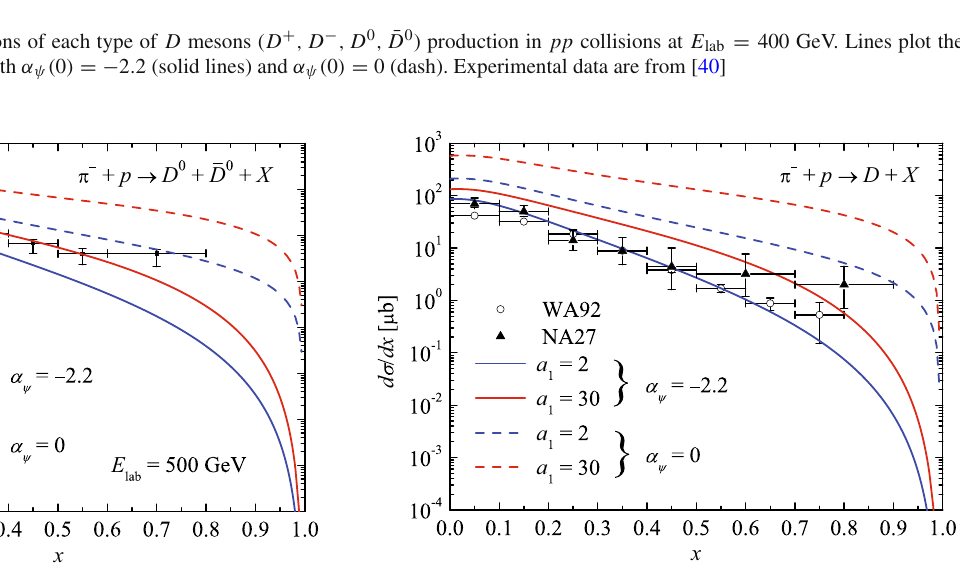
Fig. 4 Differential cross sections of D 0 / ¯ D 0 mesons production in π p collisions at E lab = 500 GeV. Experimental data are from [46]. Same notation for lines as in Fig. 3